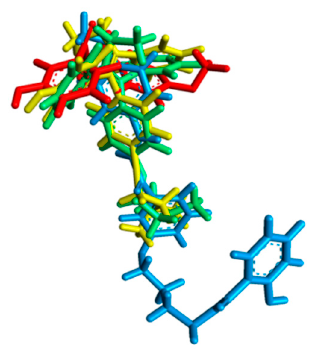
Figure 5. Superimposition of docked compounds, chalcone analogue (red), title compound (blue), tamoxifen (green), and 4-OHT (yellow).